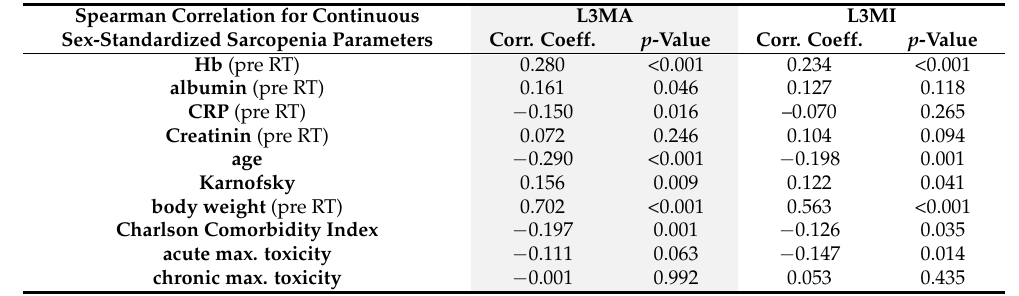
Table 2. Correlation of clinical variables with standardized pretherapeutic skeletal muscle indices L3MA and L3MI. Spearman’s rank correlation coefficients and corresponding p values are given. L3MA, calculated cross-sectional skeletal muscle area at the third lumbar vertebra; L3MI, calculated skeletal muscle index at the third lumbar vertebra; Hb, hemoglobin; RT, radiotherapy; CRP, C- reactive